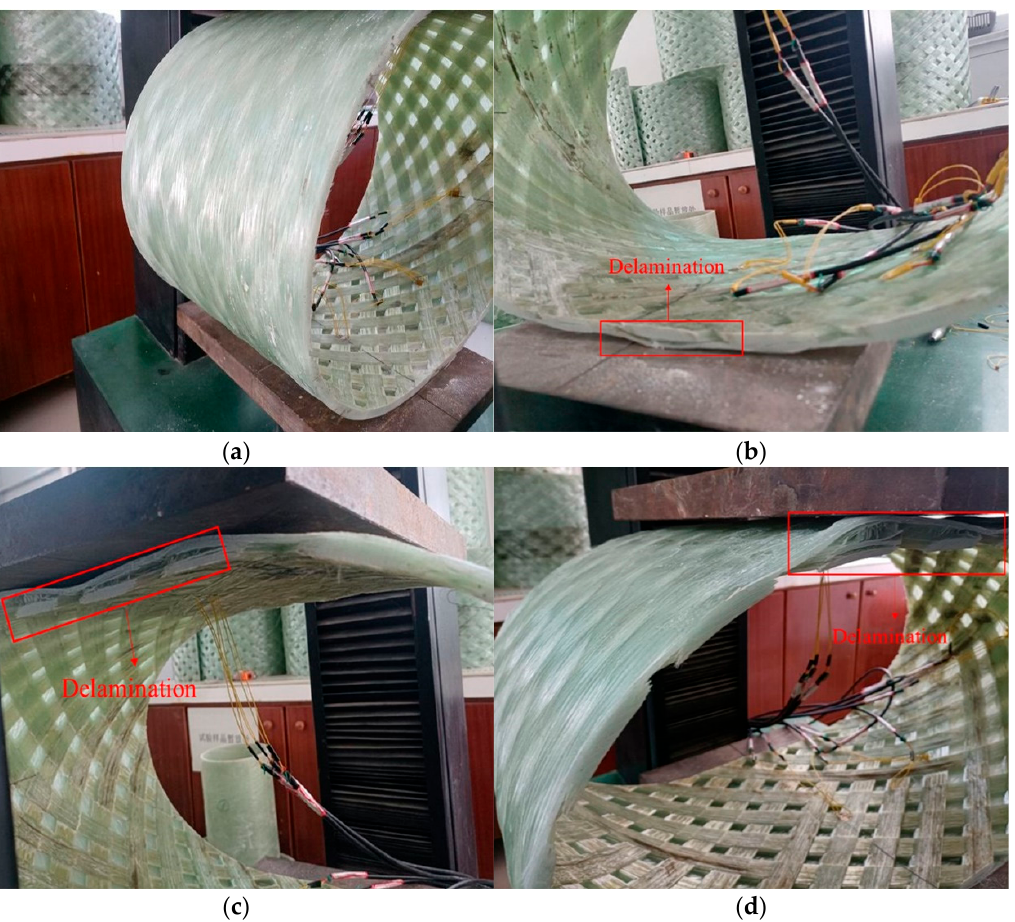
Figure 16. Deformation of inner stiffened pipes during failure phase: ( a ) 3% diametric deflection; ( b ) 15% diametric deflection; ( c ) 20% diametric deflection; ( d ) 24% diametric deflection.